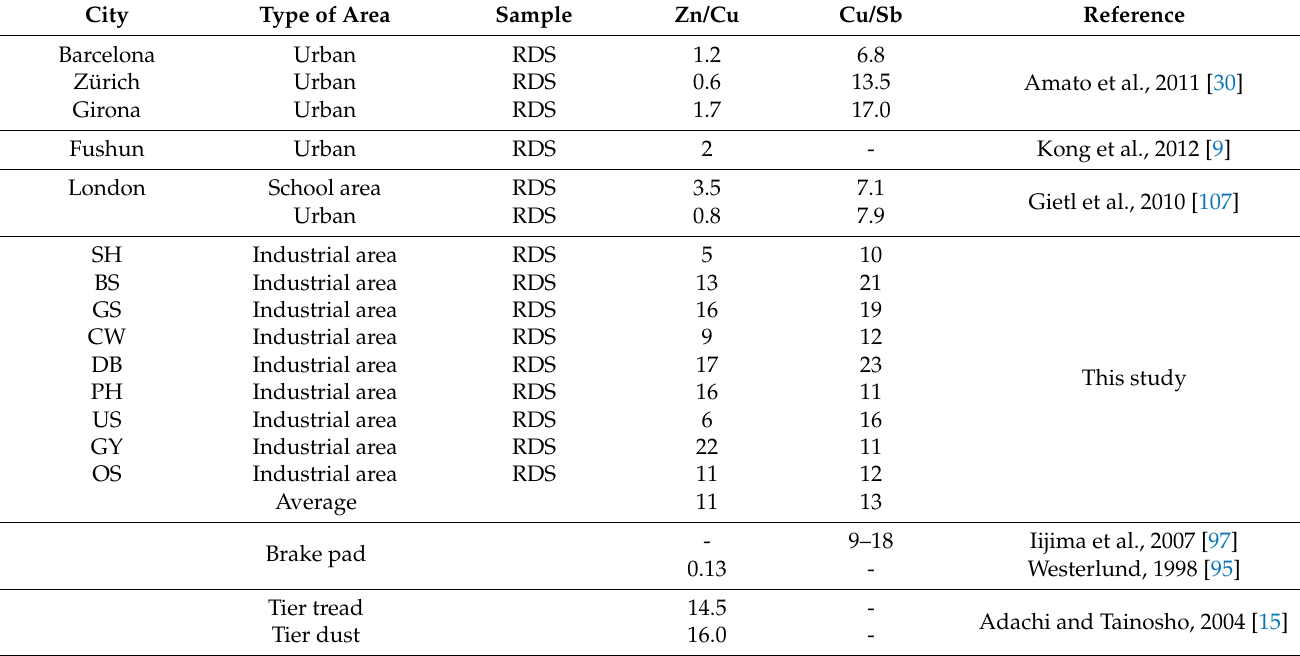
Table 7. Mean values of non-exhaust vehicle emission tracers from previous studies and this study. (-: not measured). City Type of Area Sample Zn/Cu Cu/Sb